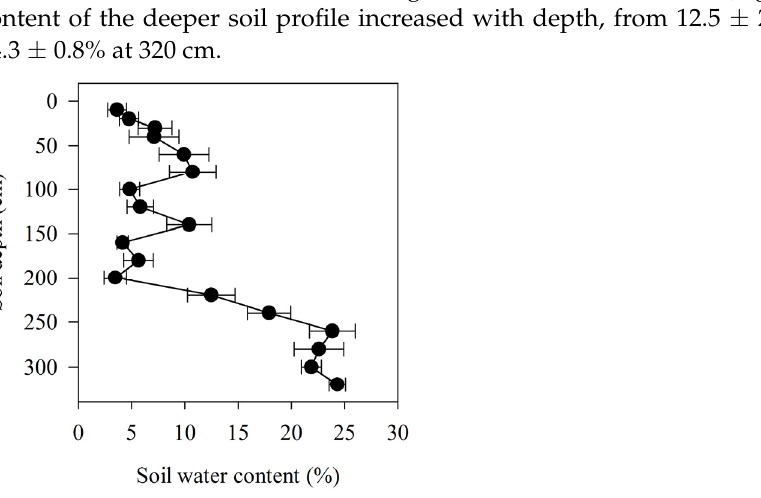
Figure 1. Soil water content relative to soil depth, collected in the lower reaches of the Heihe